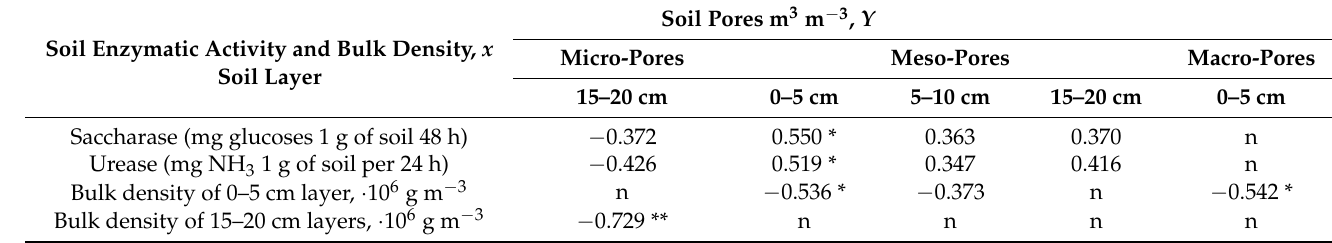
Table 3. Correlation (r) between soil enzymatic activity and bulk density ( x ) and volume of soil pores ( Y